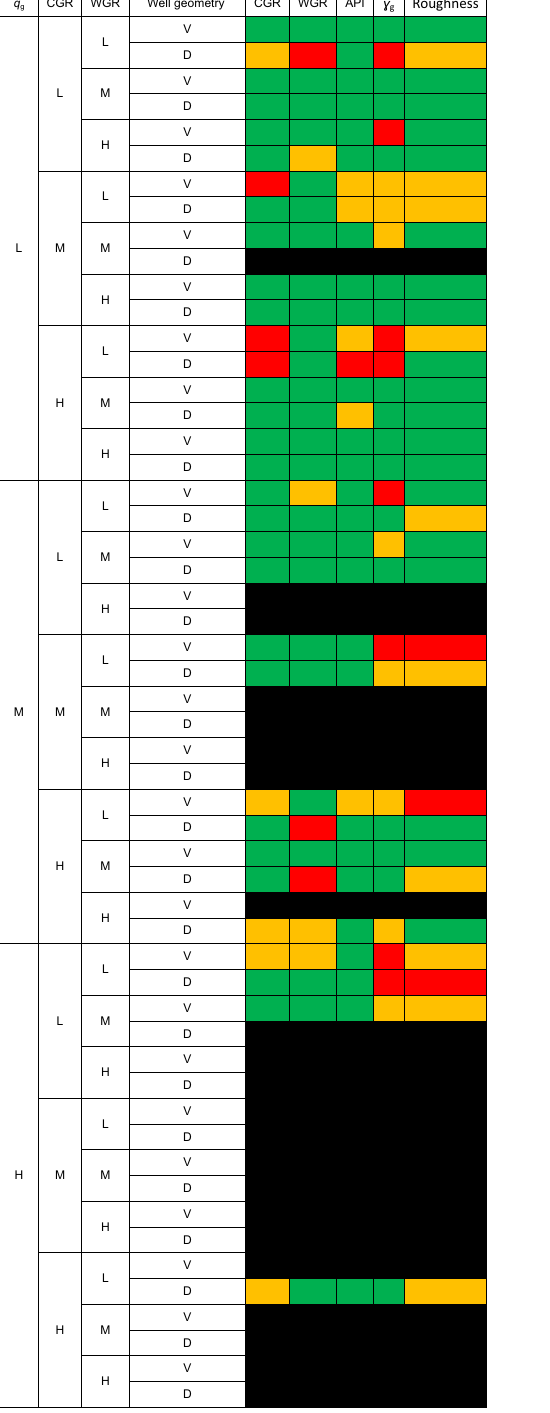
Table 6 Effect of changing input parameters on the selection of best correlation